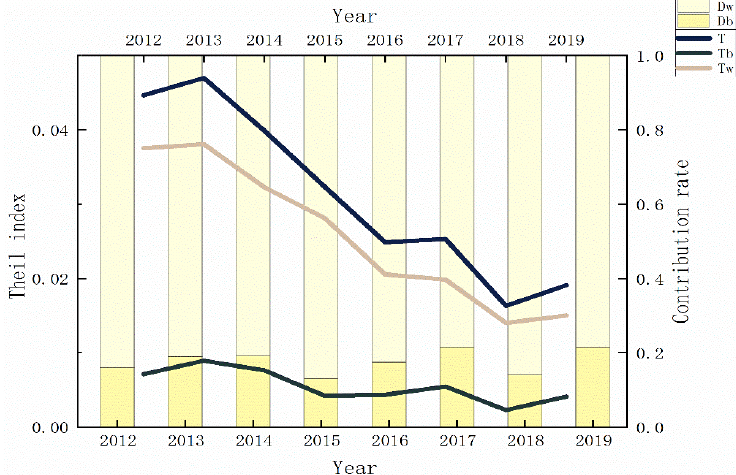
Figure 5. Theil index and regional contribution rate 2012–2019.